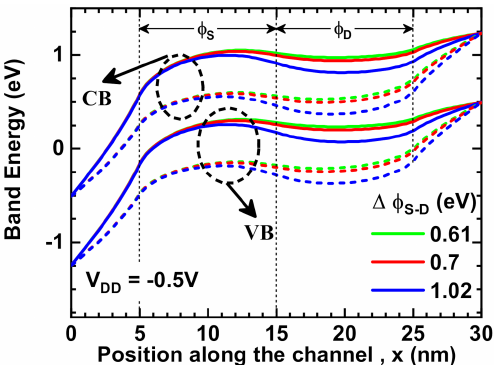
Figure 3. Conduction band (CB) and valance band (VB) profiles along the channel—dot line: off-state (V DD = − 0.5 V, V GS = 0 V), solid line: on-state (V DD = V GS = − 0.5 V).